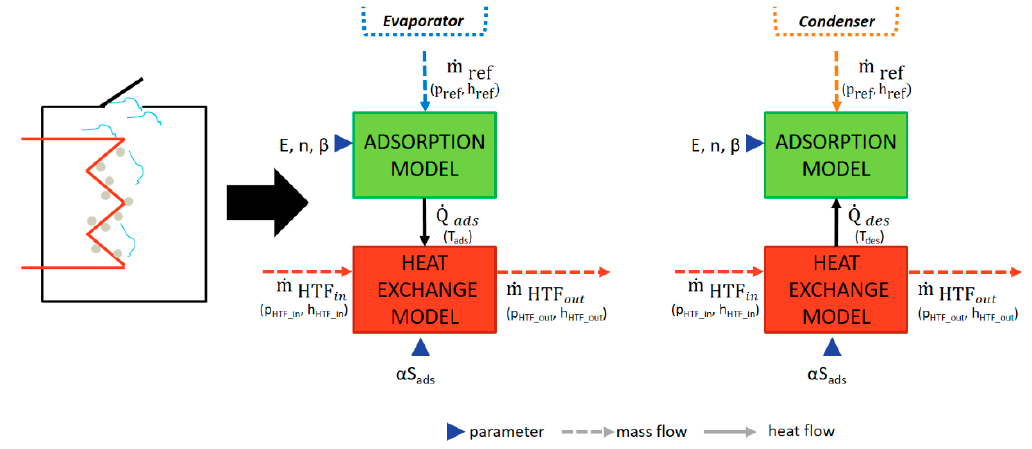
Figure 4. Representation of the evaporator/condenser (left) and its implementation, with input and output variables and energy flows for the evaporator (middle) and condenser (right).